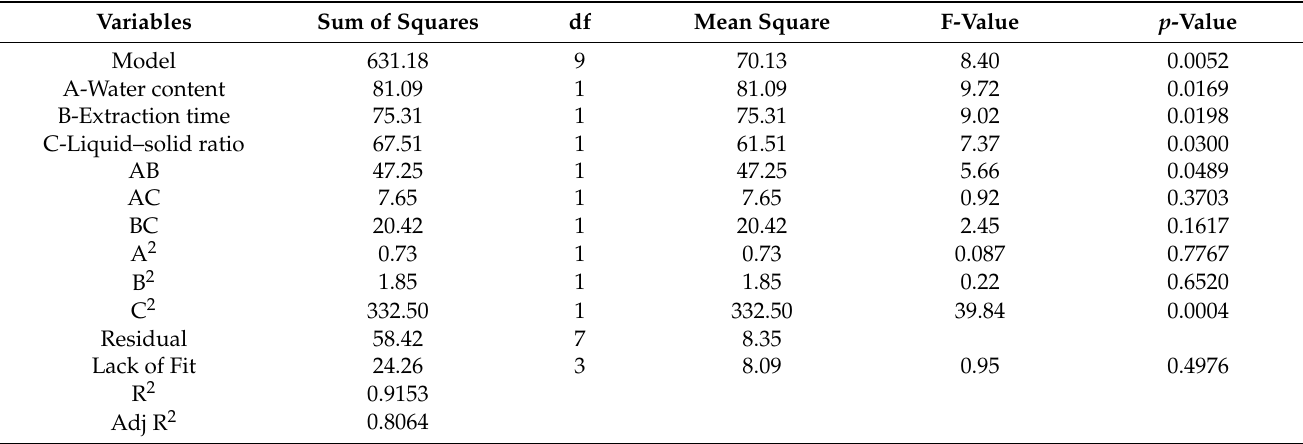
Table 4. The analysis of variance (ANOVA) results of the quadratic multiple regression model for steroidal saponins.